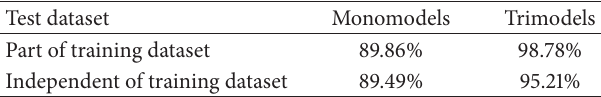
Table 2: Recognition results: monomodels versus trimodels. Table 3: Recognition results: the proposed algorithm versus Khor- sheed